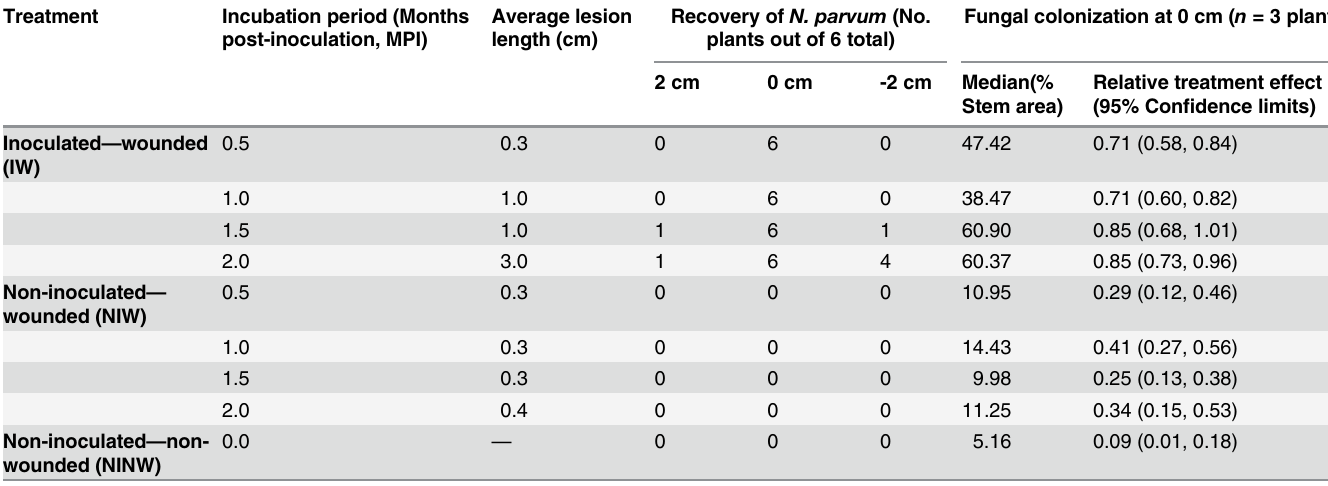
Table 1. Recovery of N . parvum was determined by culture, and fungal colonization of xylem fibers and rays was determined by light microscopy.